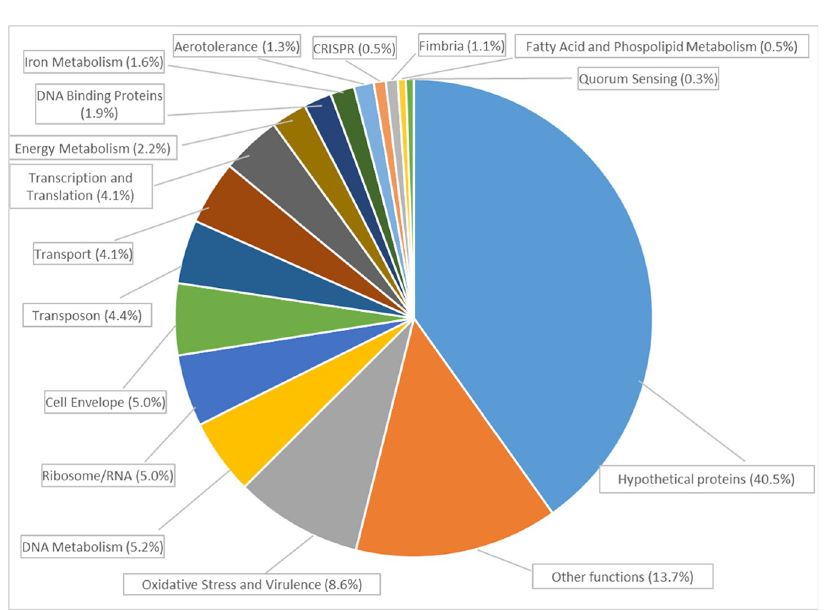
Fig 5. Distribution in functional categories of the differentially regulated genes of Porphyromonas gingivalis ATCC 33277 in planktonic cells compared to P . gingivalis within a multispecies-biofilm.